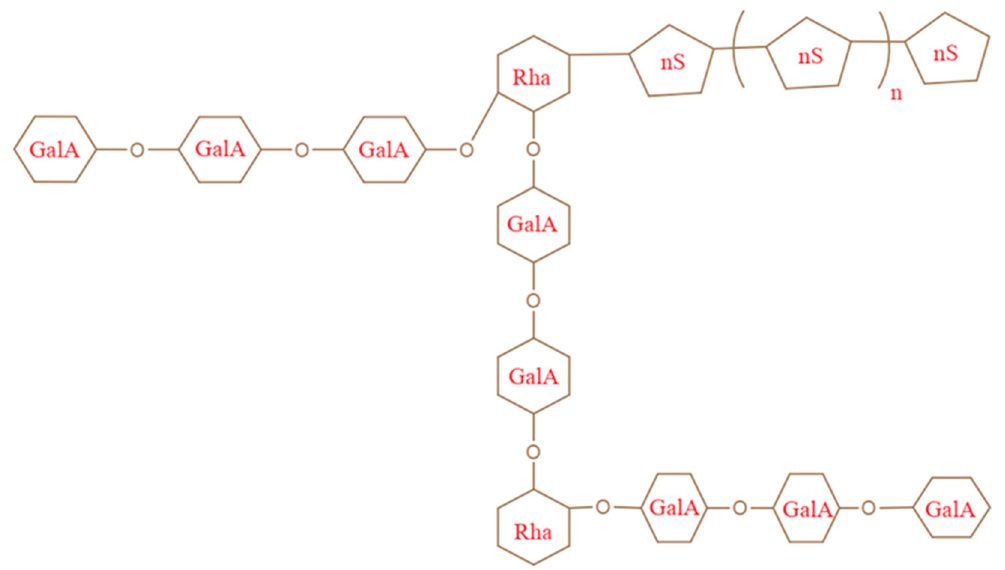
Figure 2. Rhamnose (Rha) insertion occurrence of galacturonic acid (Ga) and nS (neutral sugar). Reproduced with permission [46].